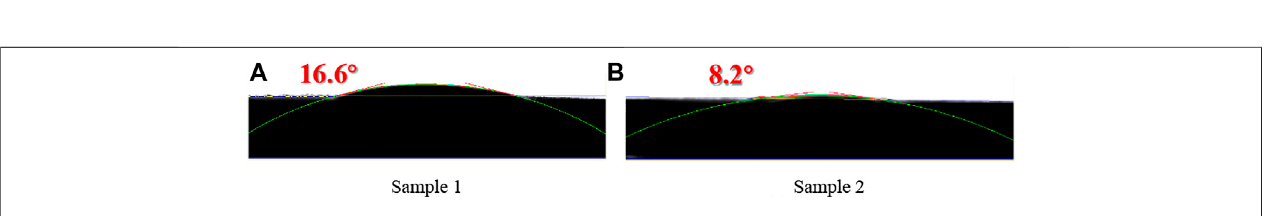
FIGURE 3 | Contact angle of two samples. (A) Sample 1. (B) Sample 2